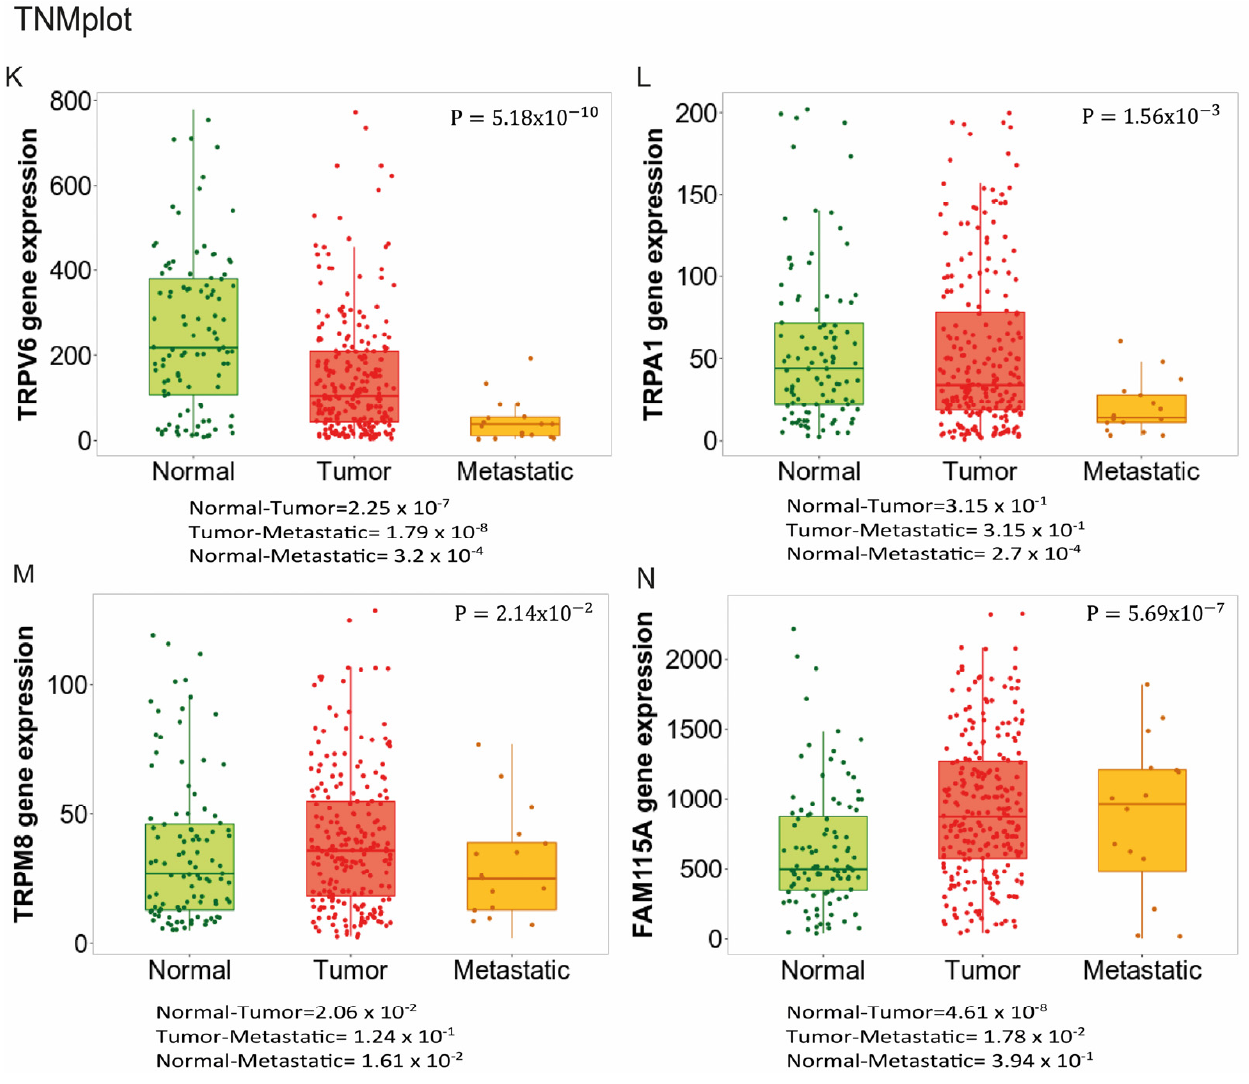
Figure 4. Correlation of the selected genes’ expression levels with clinicopathologic parameters. Boxplots for the correlation of TRPV6 expression with tumoral stage (( A )-GEPIA, ( F )-UALCAN, and ( K )-TNMplot), TRPA1 with TNM stage (( B )-GEPIA, ( G )-UALCAN, and ( L )-TNMplot), TRPM8 (( C) -GEPIA, ( H )-UALCAN, and ( M )-TNMplot), TCAF1 (( D )-GEPIA, ( I )-UALCAN, and ( N )-TNMplot), and TCAF2 (( E )-GEPIA and ( J )-UALCAN). The expression of TCAF1 was significantly higher in tumoral vs. normal tissues ( p = 4.61 × 10 − 8 ) and in tumoral vs. metastatic tissues ( p = 1.78 × 10 − 2 ), but nonsignificant in normal vs. metastatic tissues ( p = 3.94 × 10 − 1 ) (Figure 4N). TRPM8 gene expression was significantly higher in tumoral vs. normal tissues ( p = 2.06 × 10 − 2 ) and in normal vs. metastatic tissues ( p = 1.61 × 10 − 2 ). However, we found a nonsignificant difference between its expression in tumor vs. metastatic tissues ( p = 1.24 × 10 − 1 ), even though the differential expression was 0.46-fold change in metastatic versus tumor tissues (Figure 4M). To assess whether these results were reproducible, we further analyzed PDAC and non-tumoral adjacent tissues (NAT) in a cohort of Fundeni Clinical Institute